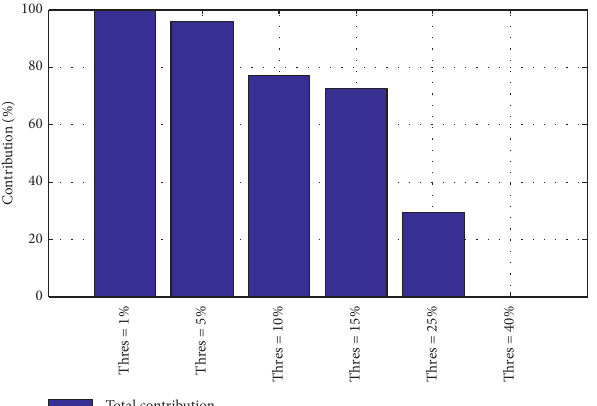
Figure 6: Total contribution of the sources according to the threshold.